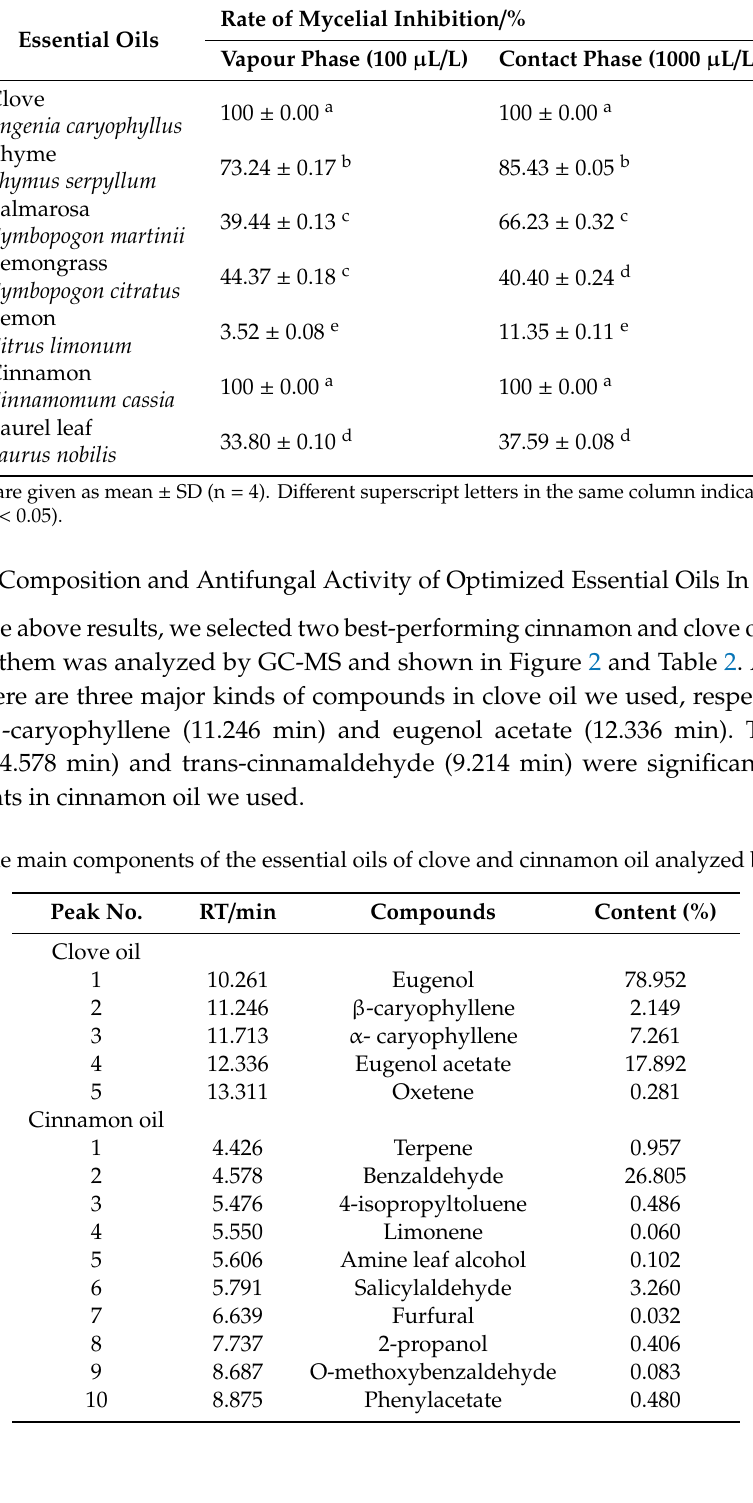
Table 1. The inhibition activity of essential oils against C. gloeosporioides .